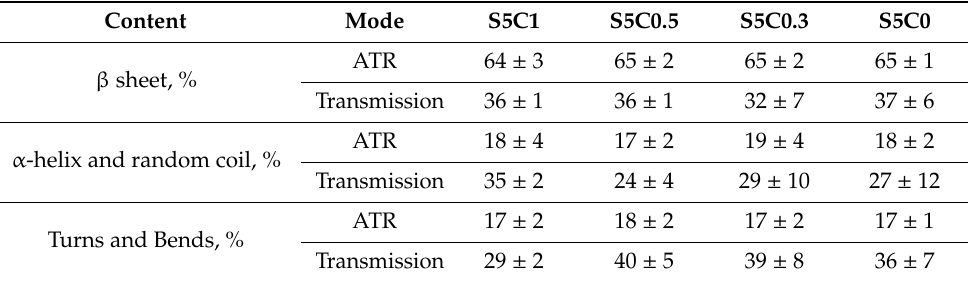
Table 1. Secondary structure ratio of silk fibroin (SF) in the SF / cellulose hydrogel hydrogels by analysis of